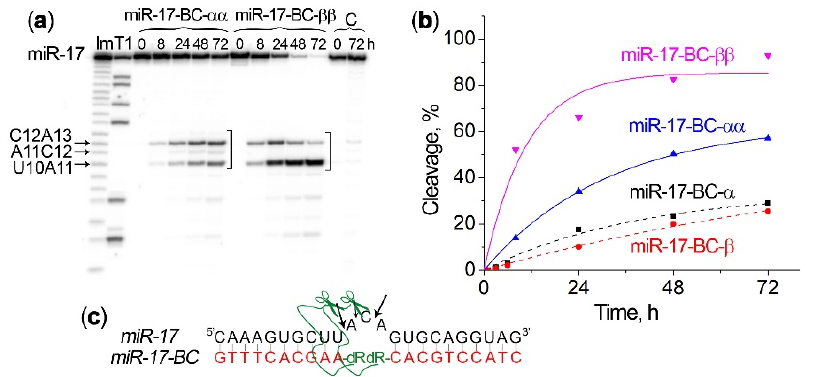
Figure 4. Kinetics of 5 (cid:48) -[ 32 P]-miR-17 cleavage by bis-conjugates miR-17–BC- αα and miR-17–BC- ββ . ( a ) Radioautograph of 18% denaturing PAAG showing the cleavage products of miR-17 in Buffer 2. miRNA-17 (1 µ M) and BCs (20 µ M) were incubated at 37 ◦ C for 72 h. Lanes Im and T1: imidazole ladder and partial RNA digestion with RNase T1, respectively; C: control, miRNA was incubated in the absence of conjugates. The incubation time is shown at the top. The square bracket indicates the bulge-loop region. ( b ) Progress curves of miR-17 cleavage by bis-miR-17–BC- αα and miR-17–BC- ββ . For comparison, the dashed curves show miR-17 cleavage by the mono-peptides miR-17–BC- α and miR-17–BC- β . ( c ) Positions of miR-17 cleavage by miR-17–BC- αα and miR-17–BC- ββ